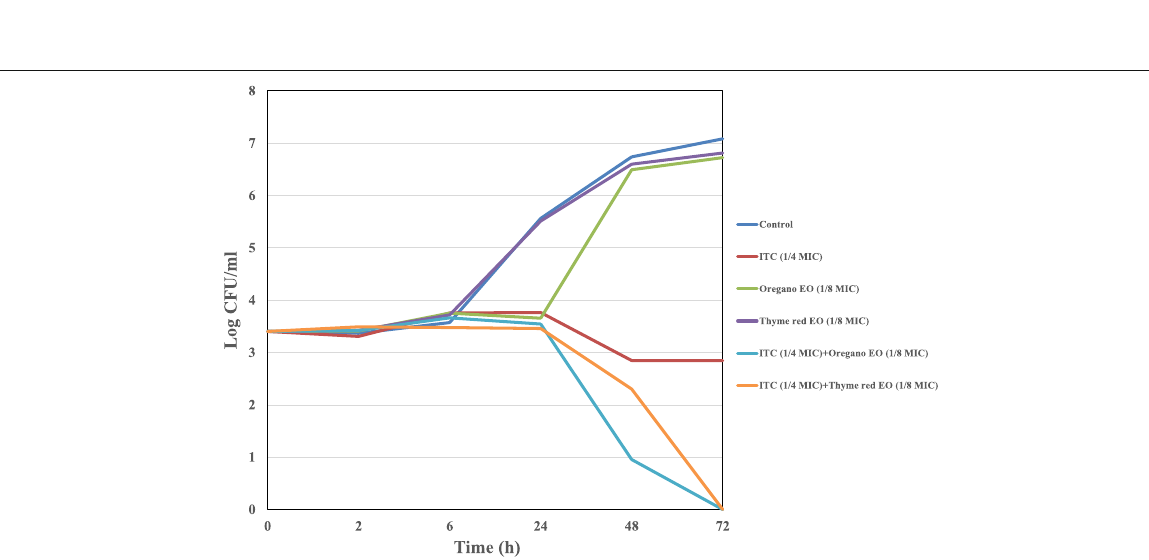
Fig. 3 Time-kill curve of ITC, oregano and thyme red EOs alone and in combination against C.neoformans ADS 37 (azole-susceptible strain)